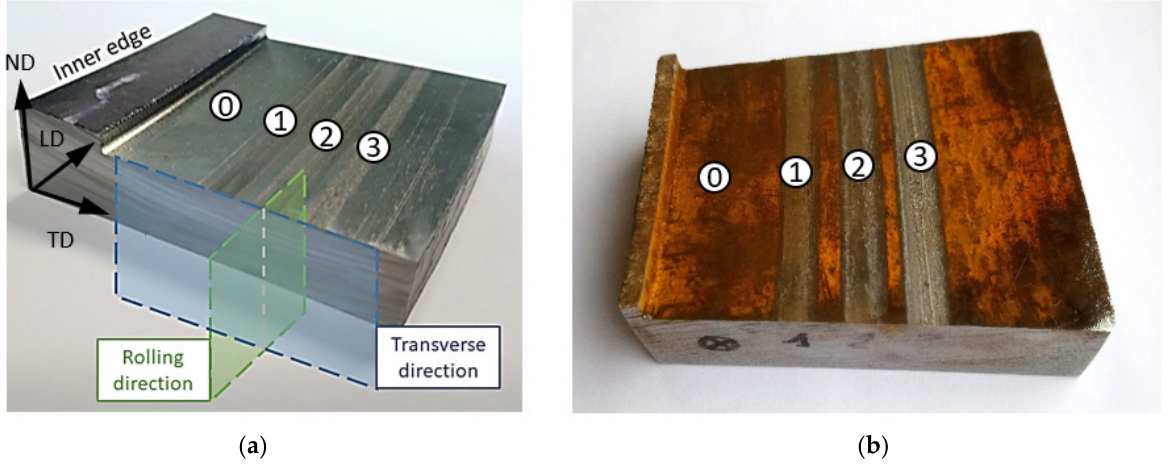
Figure 2. Images of parts of ( a ) Ring AT ( b ) Ring AT-C, with the different directions of observation and track numbers (0 stands for the non-deformed part).